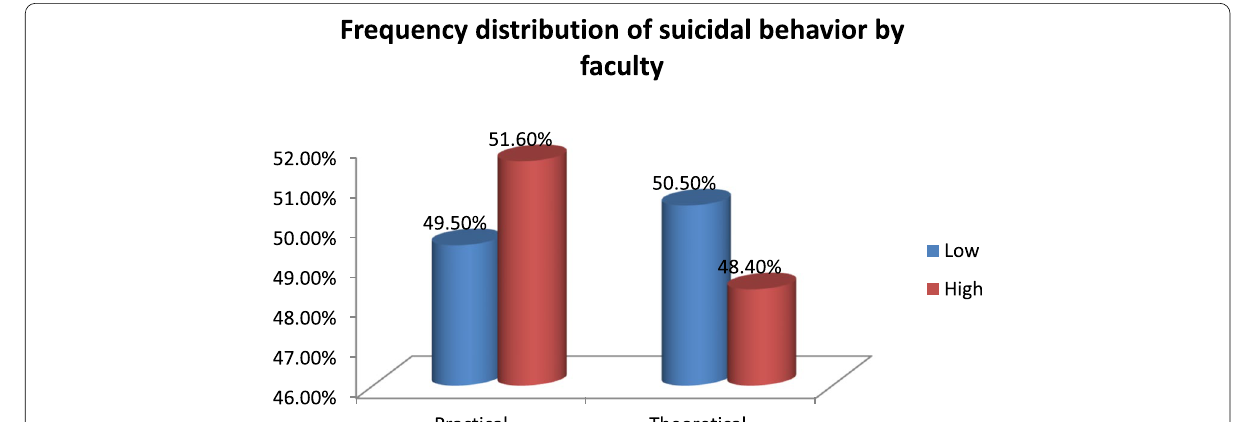
Fig. 2 Frequency distribution of the suicidal behaviors regarding the faculty type ( n